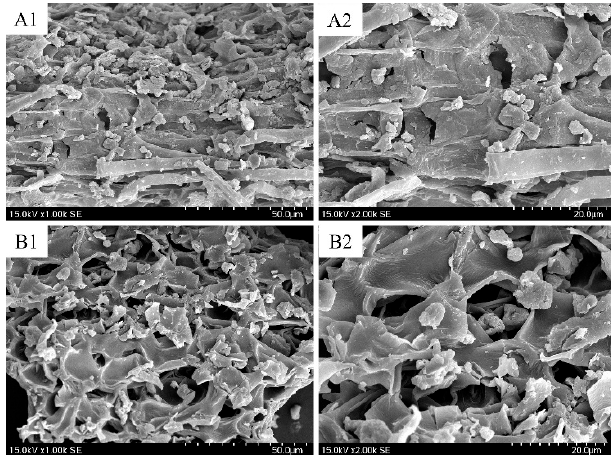
Figure 10. SEM graphics of S. sinensis before and after extraction. Raw materials ( A1 , A2 ) and treated samples by MAE-IL ( B1 , B2 ) were observed under 1000 and 2000 magnification, respectively. Table 4. Method validation for two standard compounds.